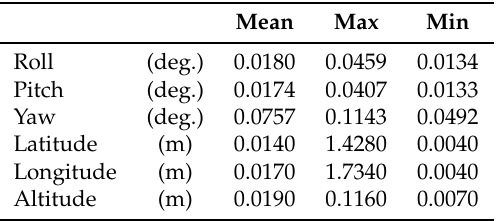
Table 4. Statistical values of the standard deviations for each navigation variable in the reference dataset for the complete